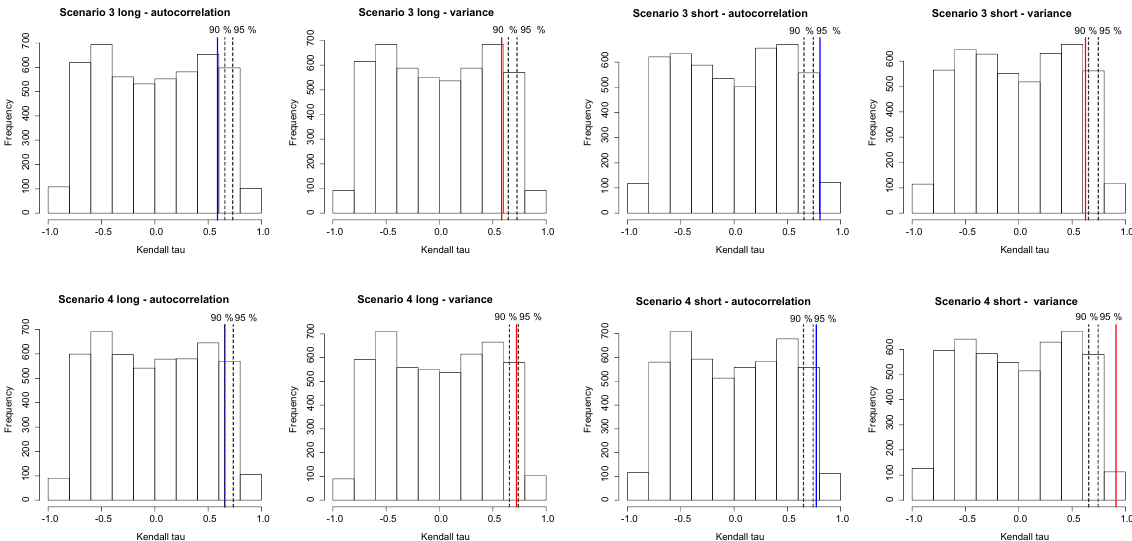
Figure 10. Histograms showing Kendall tau correlation coefficients for surrogate time series, generated from the two scenarios for which the existence of tipping points was investigated. Values relate to autocorrelation (blue lines) and variance (red lines) scores shown in Table 3. Dashed lines mark 90 and 95% confidence